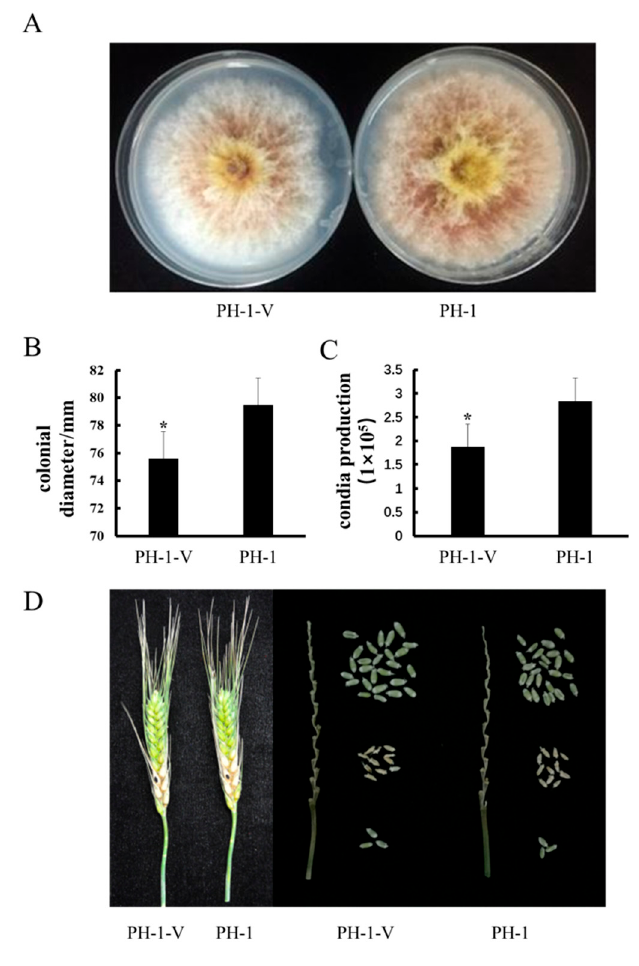
Figure 4. ( A ) Colony morphology of strain PH-1-V (virus-carrying) and PH-1 (virus-free) after 4 days of culture on PDA in the dark. ( B ) Colony diameter of strains PH-1-V and PH-1after 4 days of culture on PDA in the dark. “*” indicates a significant di ff erence ( p < 0.05). ( C ) Conidial production of strains PH-1-V and PH-1 after 5 days in CMC medium. “*” indicates a significant di ff erence ( p < 0.05). ( D ) Fusarium head blight symptoms caused by PH-1-V and PH-1 fungi in the fields. On the left side, the disease symptoms infected by virus-carrying and virus-free conidia were photographed after 15 days of inoculation in the flowering stage. The black dots on the wheat kernels indicate the inoculation positions. On the right side, PH-1-V- and PH-1-infected kernels were picked from stalks. Spikelets in the middle which were infected with virus-carrying and virus-free Fusarium strains were shriveled. Pathogenicity tests were repeated three times and replicated with at least 15 wheat heads for each strain.